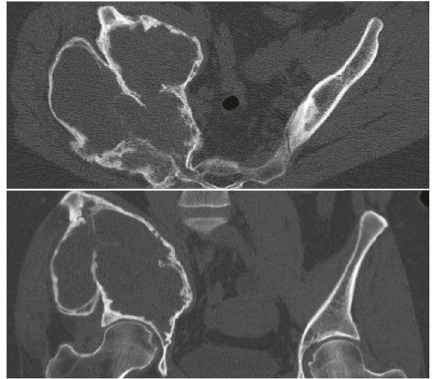
Figure 2: Preoperative follow-up CT scan showing a notable increase in cortical